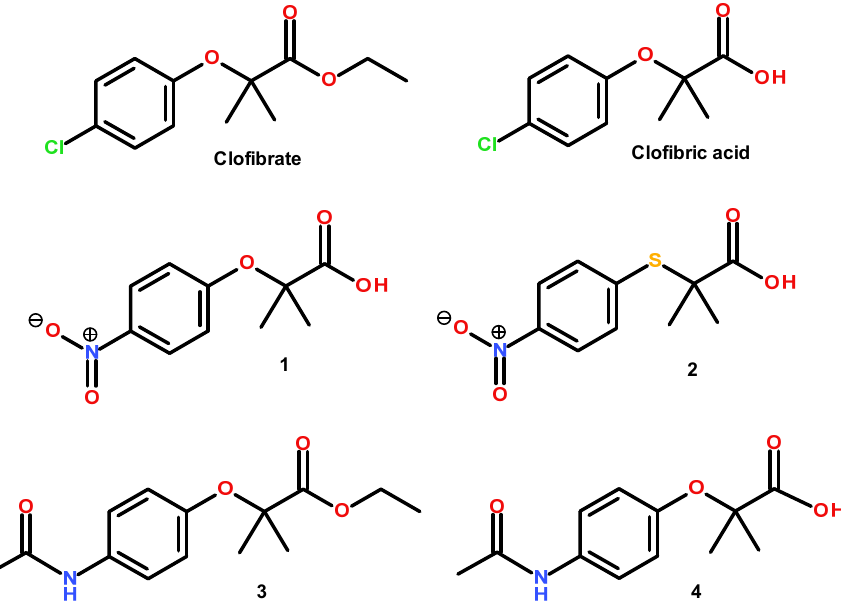
Figure 1. PPAR α modulators clofibrate and clofibric acid, containing phenoxyisobutyric acid phar- macophore, and the nitrocompounds ( 1–2 ) and acetamide compounds ( 3–4 ) designed in this work.